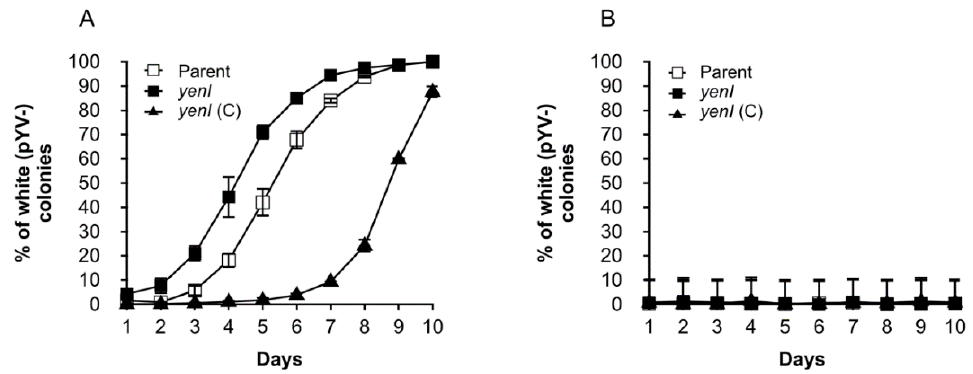
Figure 5. Expression of spyA over 12 h in the parent and QS mutants at 37 °C. The expression of the P spyA :: luxCDABE promotor fusion was comparable for the parent and yenR / ycoR mutant but was reduced ~4-fold in the yenI and yenI / yenR / ycoR mutants.